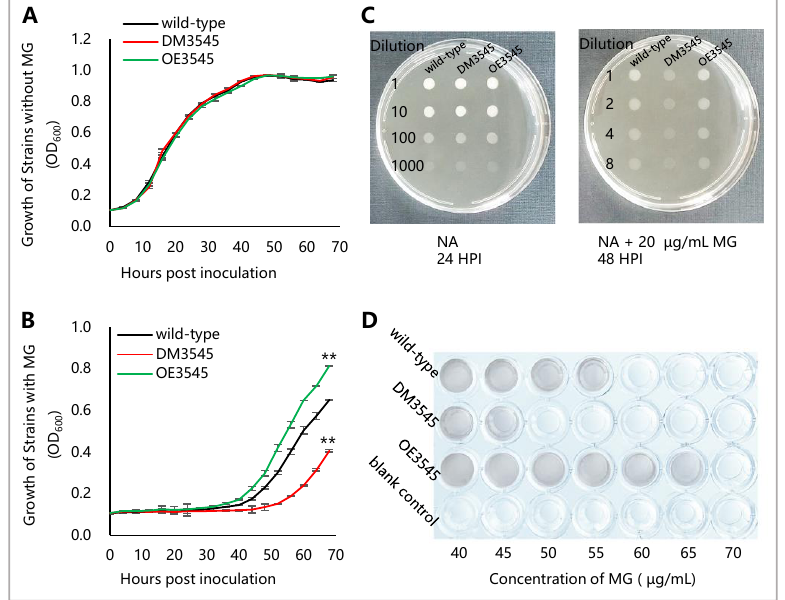
Figure 1. YceI is important for growth adaptability to MG in R. solanacearum . ( A ) Growth of the strains in NA liquid medium. ( B ) Growth of the strains in NA liquid medium with 20 µg/mL MG. Growth differences between mutants and the wild-type strain at 68 h post inoculation (HPI) are marked with asterisks, indicating p < 0.01 (**), which was compared with wild-type and statistically analyzed by ANOVA, based on Fisher’s LSD test. ( C ) Gradient diluted bacterial cultures were inoculated on NA medium with or without 20 µg/mL of MG. The growth of R. solanacearum strains was observed and photographed at 24 or 48 HPI. ( D ) Minimum bactericidal concentration (MBC) of MG against R. solanacearum . The wells of blank control were uninoculated NA liquid medium. After 96 h of incubation in 96-well plates, the wells that were free of turbidity indicated that the stains were inhibited by a special concentration of MG.